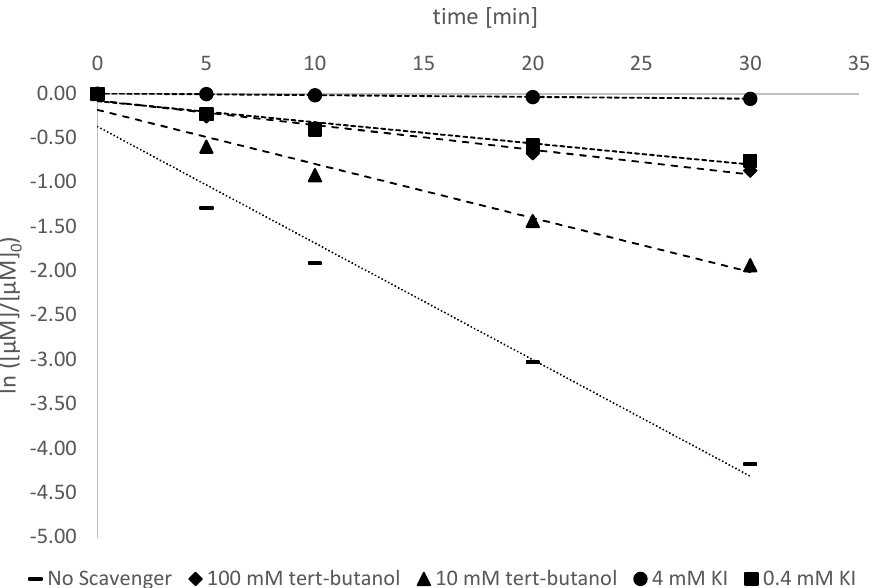
Figure 7. Trend of first-order kinetics following selective inhibitions with tert-Butanol and KI. Values refer to Z9-Ps.